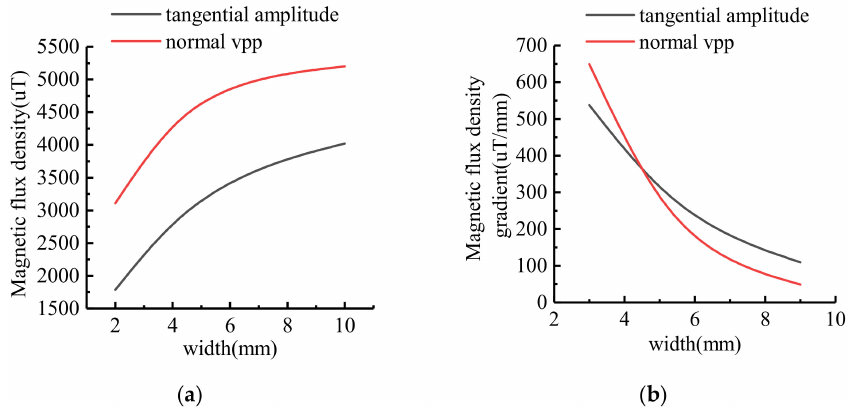
Figure 12. The variation trend of signal characteristics at different widths: ( a ) Signal variation curve; ( b ) Signal gradient variation curve.